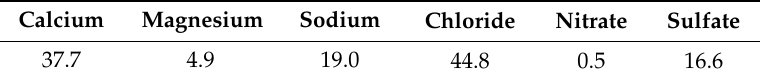
Table 1. Ionic composition (major ions) of Esbjerg tab water (mg /